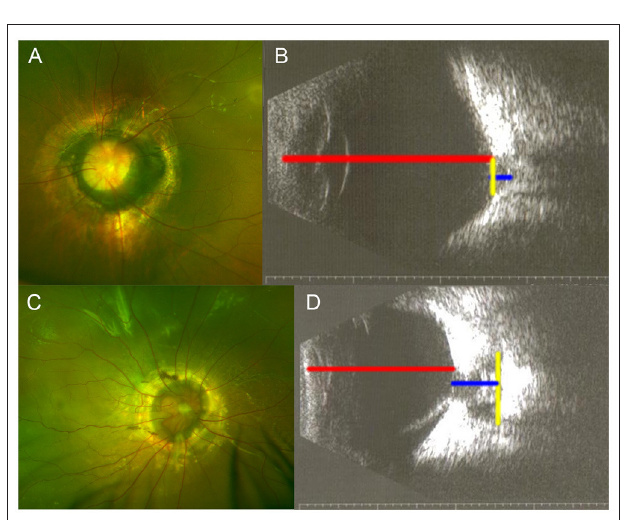
FIGURE 2 | Samples of echographic measurement with printed images. (A,B) One eye of morning glory disc anomaly (MGDA) without retinal detachment (RD). (C,D) One eye of MGDA with RD. Red line, axial length; blue line, maximal cavitary depth; yellow line, maximal cavitary